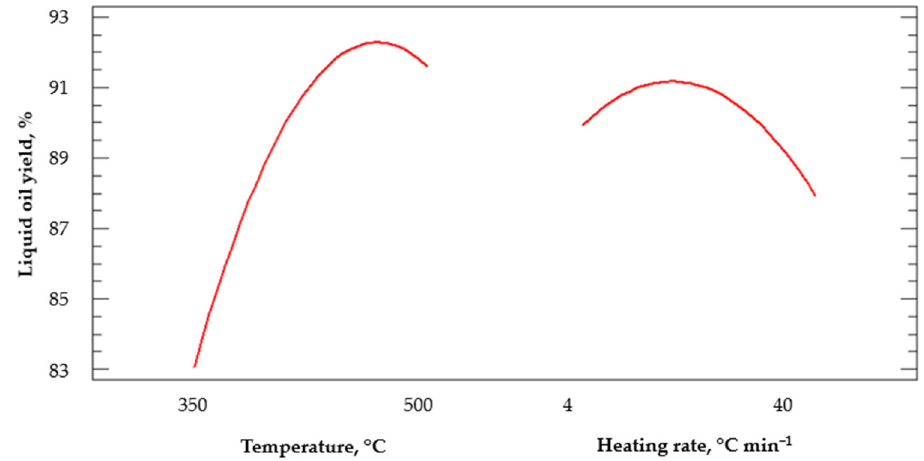
Figure 7. Main effects on the liquid oil yield.